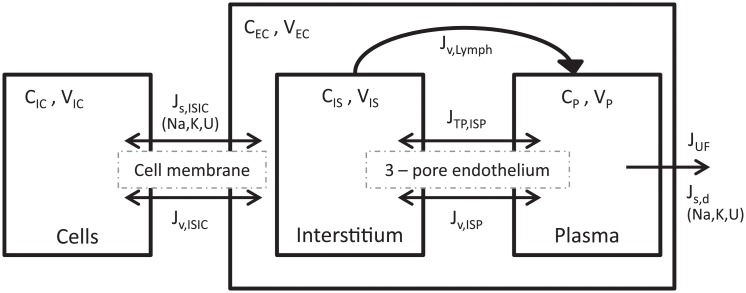
Structure of the model.Each of the three compartments, vascular (P), interstitial (IS) and intracellular (IC), is described in terms of fluid volume (V) and concentration of solutes (C). Protein (TP) mass is divided among interstitial and plasma compartments, and proteins move across the capillary endothelium according to a 3-pore membrane model. Small solute mass is divided between intra- and extracellular spaces; solute concentration in interstitium and plasma is assumed to be constantly offset by 2% at all times. Water is removed by ultrafiltration (JUF) from the plasma compartment, and small solutes are removed by diffusion and convection by the dialyzer. Jv—fluid flows; Js—solute flows between compartments Js,d—solute flows to dialyzer; ISIC—interstitial to intracellular; ISP—interstitial to plasma; U—urea.